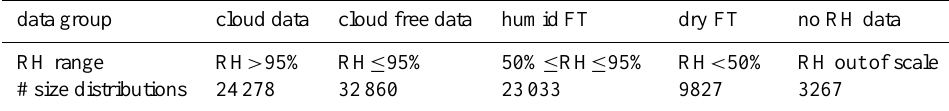
Table 1. Classification of the particle number size distributions into five groups according to different levels of relative humidity (RH). data group